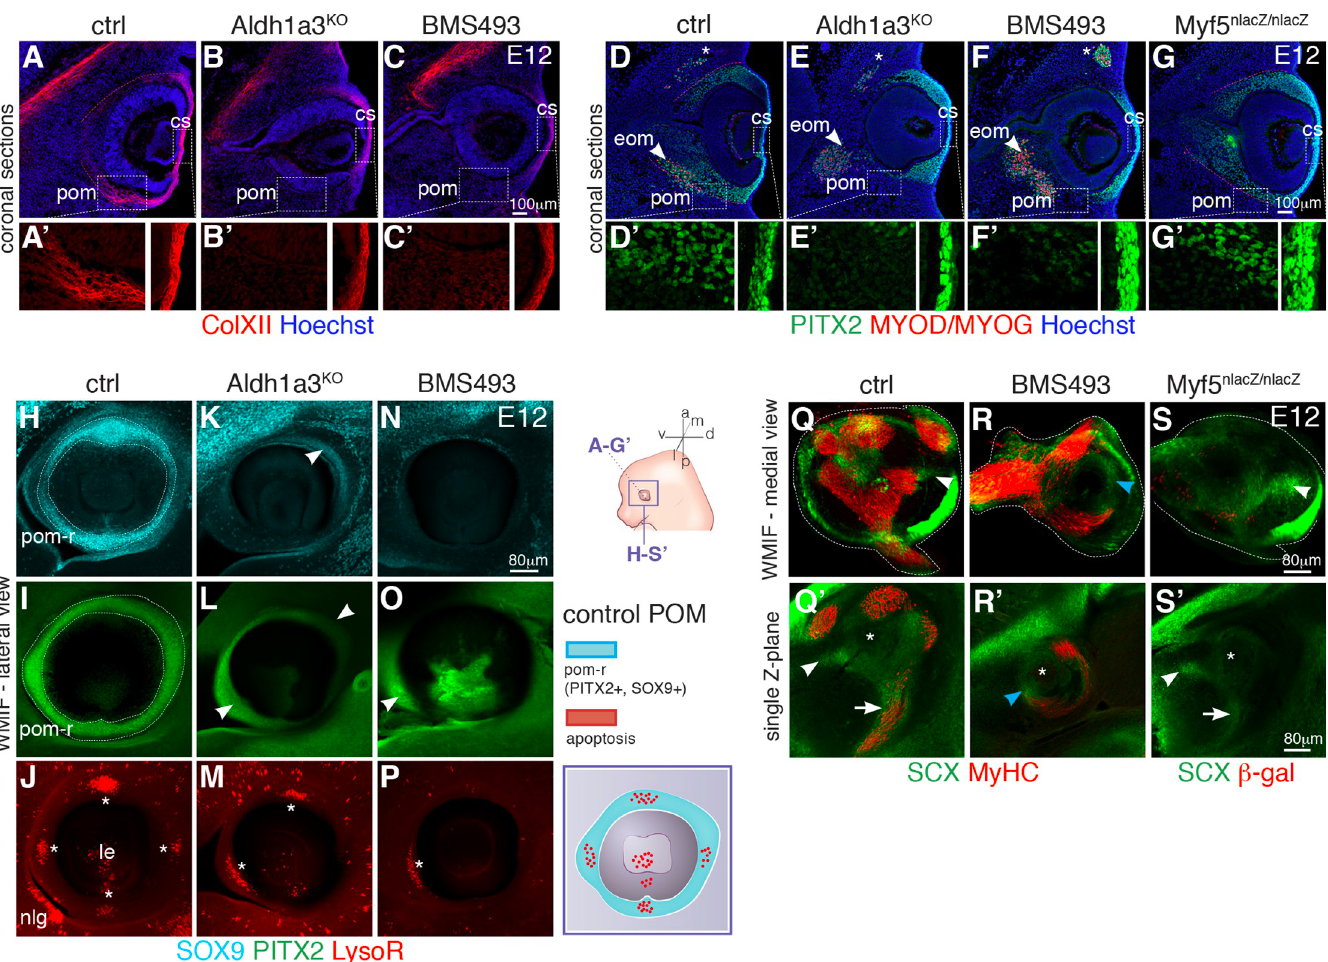
Fig 6. Altered EOM insertions in the POM upon ATRA deficiency. (A-C’) Immunostaining for ColXII on E12 coronal sections. ColXII expression is lost in the medial POM (future sclera) but not in the corneal stroma of Aldh1a3 KO ( B,B’ ) and BMS493-treated embryos ( C,C’ ). Higher magnification of ColXII staining as insets in ( A’-C’ ). (D-G) Immunostaining for PITX2 (muscle progenitors, POM) and MYOD/MYOG (myogenic cells) on E12 coronal sections. Asterisks indicate superior oblique muscle. Red dashed lines delimitate the POM in controls ( D ) and Myf5 nlacZ ( G ) embryos. Higher magnification of PITX2 staining as insets in ( D’-G’ ). Note absence of PITX2 expression in medial-POM of Aldh1a3 KO ( E,E’ ) and BMS493-treated embryos ( F,F’ ). (H-P) WMIF for SOX9 and PITX2 of E12 control ( H-J ), Aldh1a3 KO ( K-M ) and BMS493-treated ( N-P ) embryos preincubated with LysoR (left eyes). Aldh1a3 KO and BMS493 embryos do not show a complete POM-ring as controls (dashed lines in H,I ). Arrowheads mark remaining expression of SOX9/PITX2 in the POM of Aldh1a3 KO ( K,L ) or inhibitor-treated ( O ) embryos. Asterisks in ( J, M, P ) mark apoptosis spots in POM. (Q-R) WMIF for MyHC (myofibers) and GFP on E12 control ( Q ) and BMS493-treated Tg : Scx-GFP embryos ( R ). WMIF for β - gal (myogenic progenitors) and GFP on E12 Tg : Scx-GFP;Myf5 nlacZ/nlacZ E12 embryos ( S ) (left eyes). The periocular area was segmented from adjacent structures for ease on visualization (dashed lines). White arrowheads in Q and S highlight correct position of tendon condensations for medial rectus muscle. Blue arrowhead in R marks a diffuse Scx-GFP + pattern at the position of the mispatterned medial rectus muscle. ( Q’-S’ ) Single Z-section of the segmented volume. White arrowheads in Q’,S’ show tendon tips and white arrows correct Scx-GFP + connective tissue pattern along with muscle ( Q’ ) or prospective muscle masses ( S’ ). Blue arrowhead in R’ marks a Scx-GFP + condensation at the muscle tip. Asterisks mark position of the optic nerve. ( n = 3 per condition). a, anterior; ATRA, all-trans retinoic acid; cs, corneal stroma; ctrl, control; d, dorsal; eom, extraocular muscles; l, lateral; le, lens; LysoR, LysoTracker red; m, medial; nlg, nasolacrimal gland; p, posterior; pom, periocular mesenchyme; pom-r, periocular mesenchyme ring; v, ventral; WMIF, whole-mount